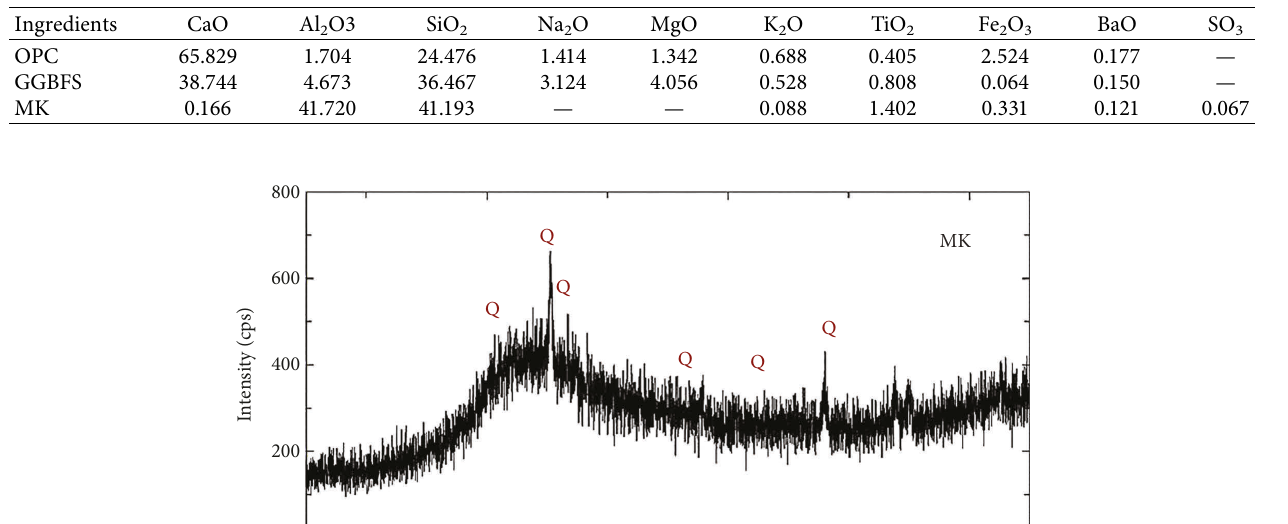
Table 1: Chemical analysis of undisturbed materials used using EDXRF.